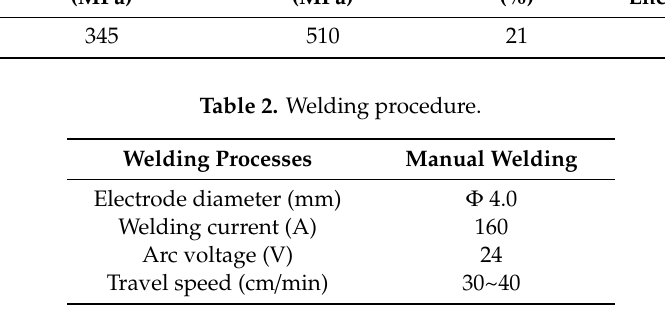
Figure 8. Stress–node position curves of the rounded welding region in the specimen. Table 1. Mechanical properties of Q345qD.